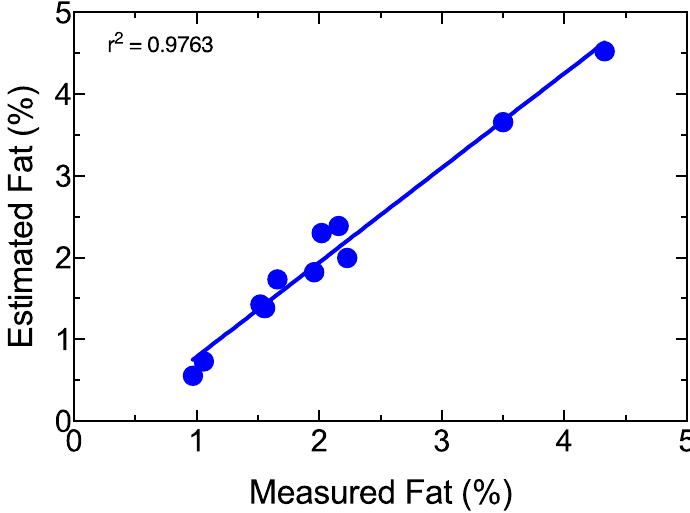
Figure 8. Validation results of the fat model.